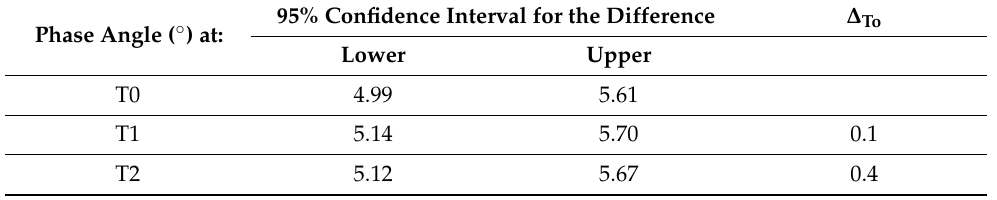
Table 4. Cyclotron—lower and upper values of phase angle (Xc/Rz × 180/ π ). The delta of the average phase angle values (°) are included.